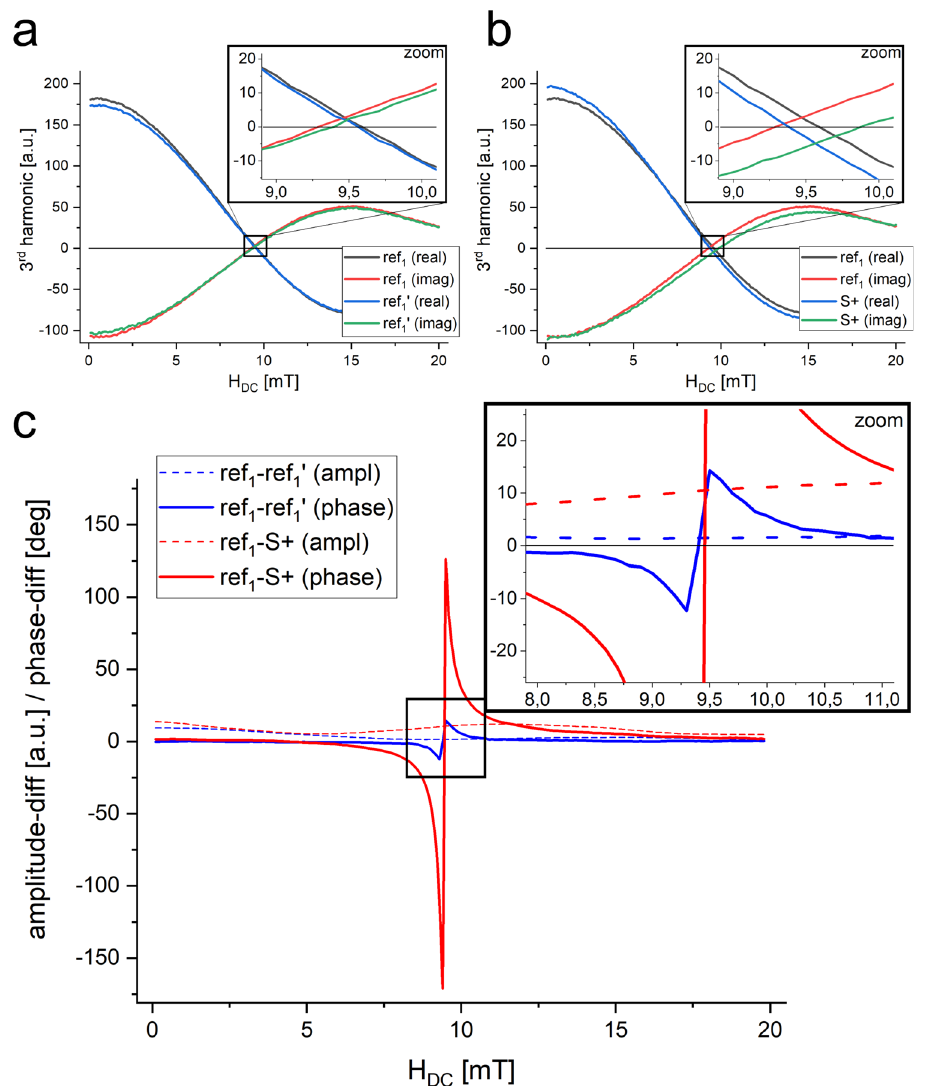
Fig. 3 | Critical point sensitivity. a , b The real and imaginary parts for the third harmonic ( H AC =17mT) of experiments with a reference sample ( ref 1 & ref 1 ’ ) and a reference sample and a binding sample ( ref 1 & S +). The differences in the crossing